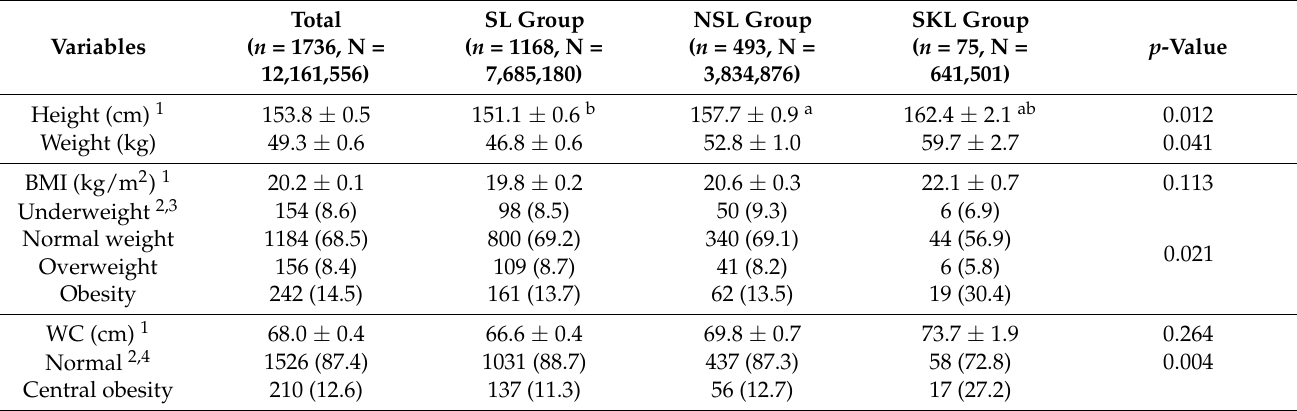
Table 2. Anthropometric measurements according to lunch type among children and adolescents